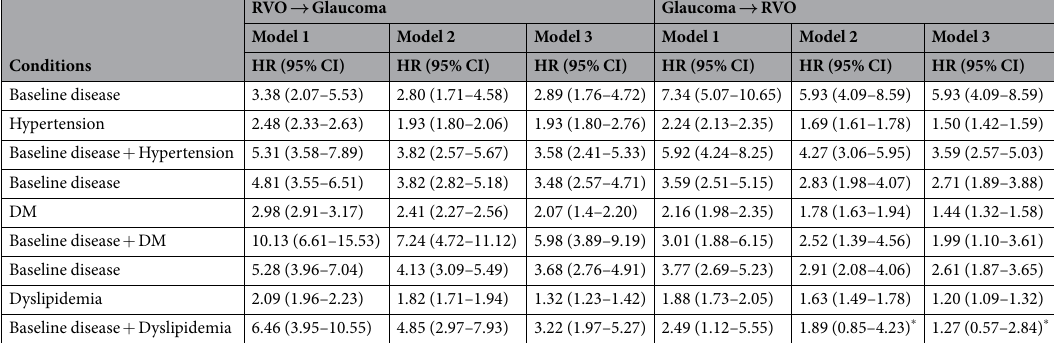
Table 5. Multivariate cox regression analysis for development of primary open angle glaucoma or retinal vein occlusion in subjects with and without the baseline diseases (either retinal vein occlusion or glaucoma, respectively). Model 1: not adjusted. Model 2: adjusted for age and gender. Model 3: adjusted for age, gender, income, residential area. All P values < 0.001 except for *